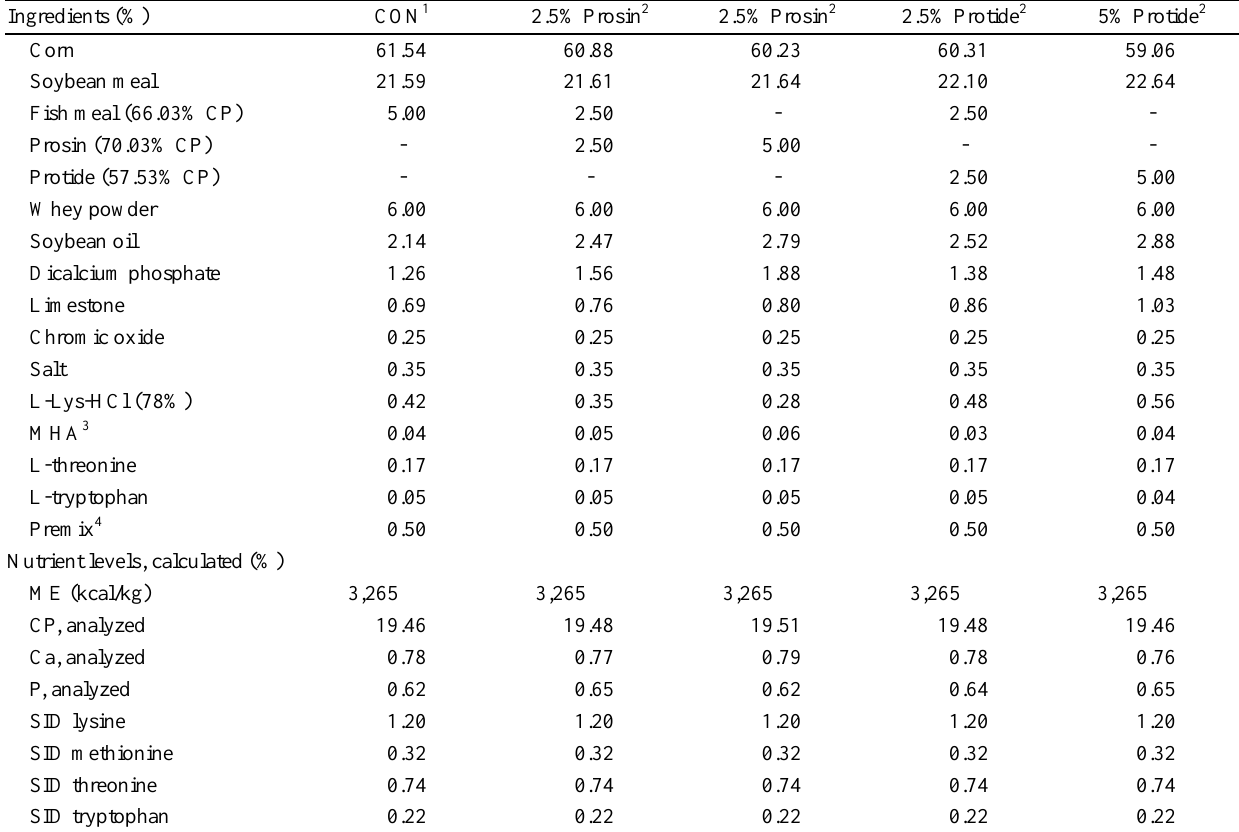
Table 4. Ingredient composition of experimental diets containing fish meal and single-cell proteins (Prosin and Protide) (as-fed